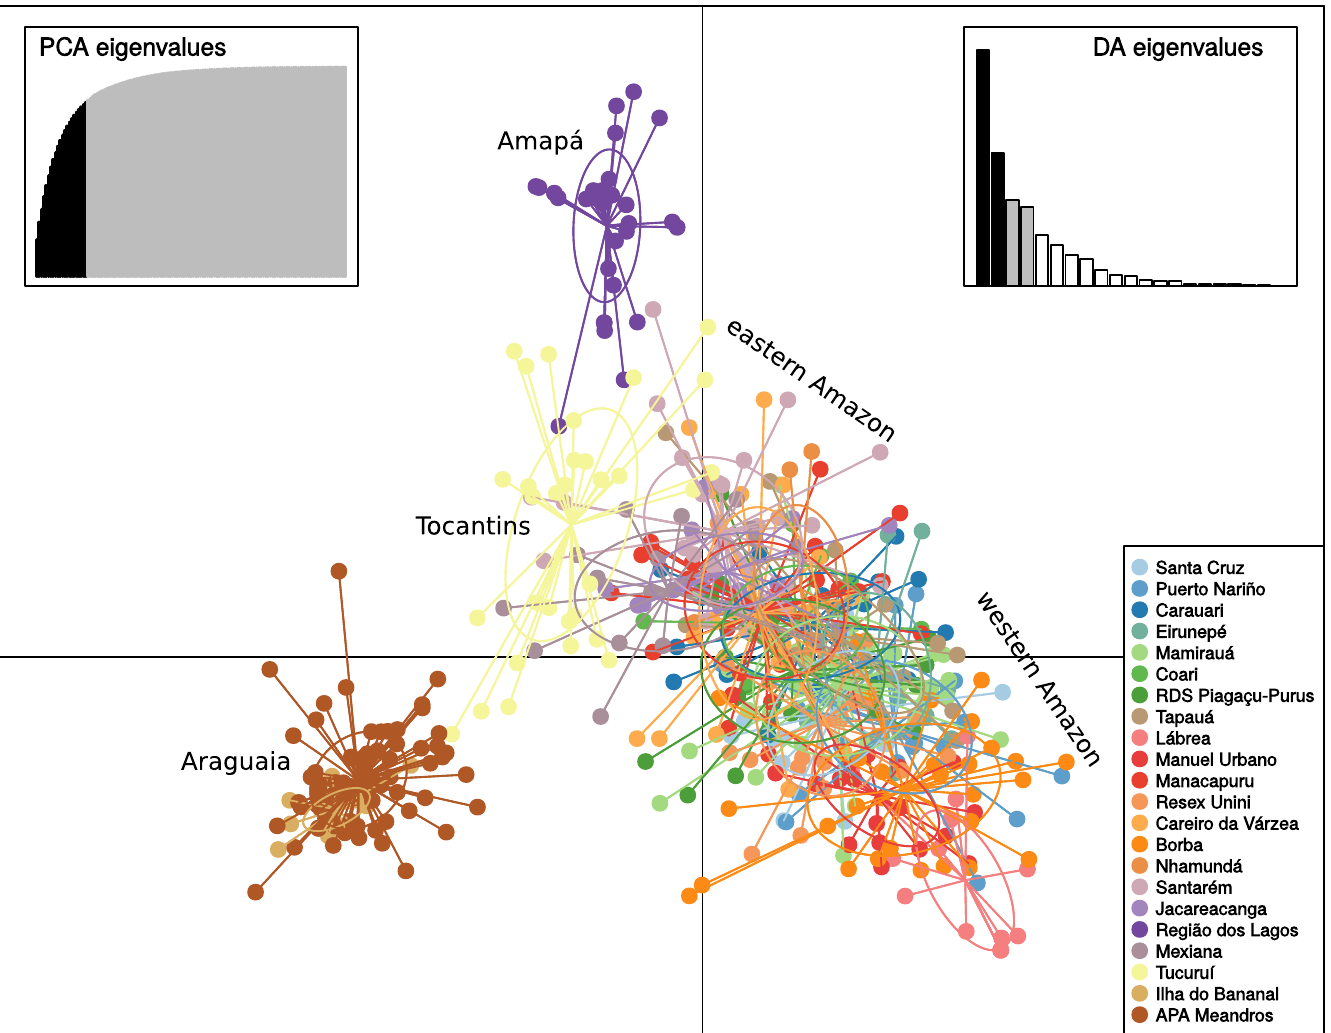
Fig 3. Results of DAPC analysis showing the scatterplot of the first two principal components based on 11 microsatellite loci of 511 individuals of Arapaima gigas from 22 sampling locations. The results are plotted showing an ellipse that shows one standard deviation of the variation of each population relative to its centroid. The eastern Amazon and western Amazon labels designate concentration of localities from these geographic